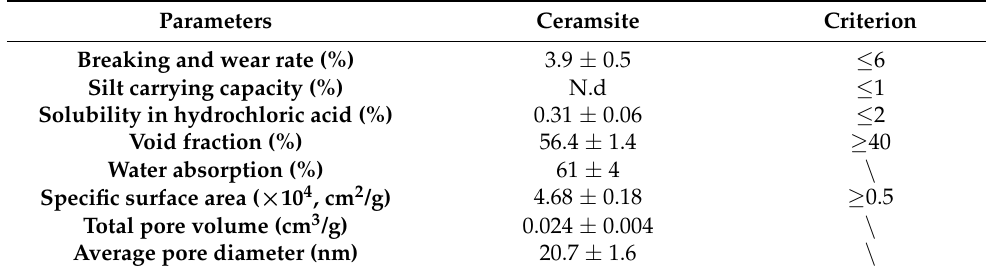
Table 3. Physical characteristics of ceramsite.